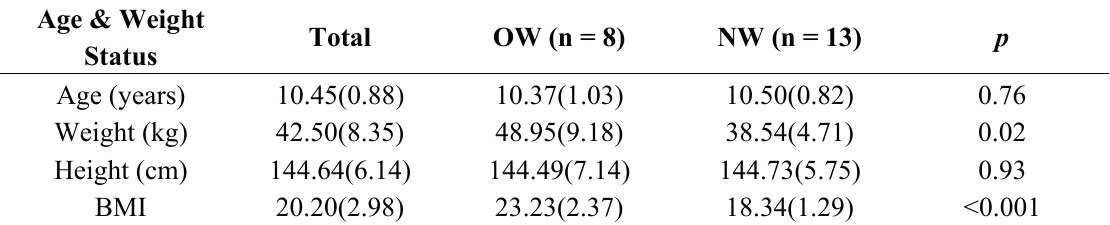
Table 1. Participants’ characteristics by weight